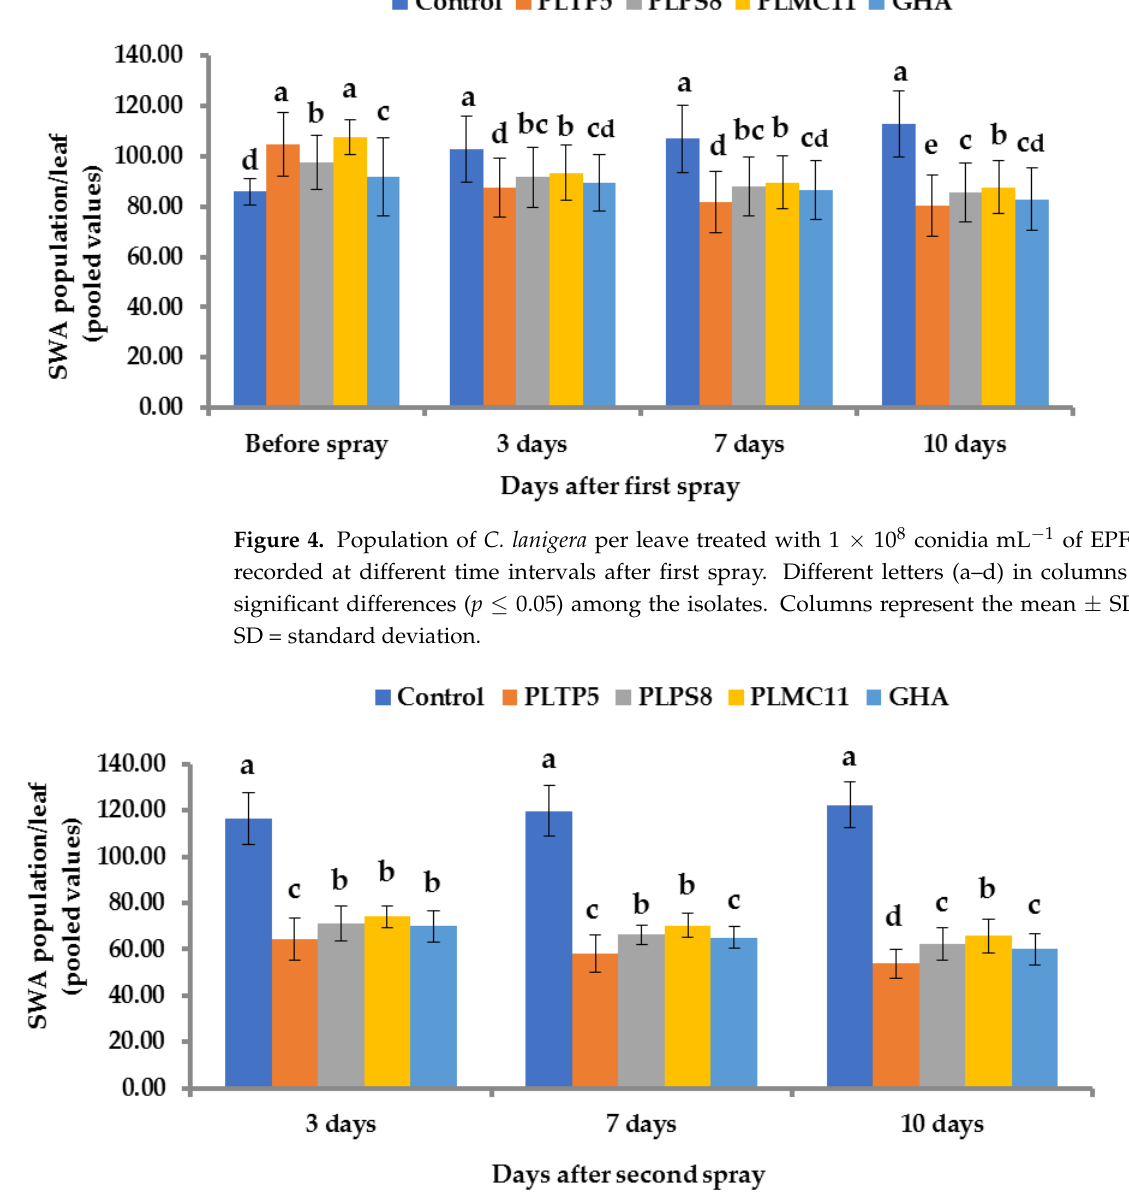
Figure 5. Population of C. lanigera per leave treated with 1 × 10 8 conidia mL − 1 of EPF isolates, recorded at different time intervals after second spray. Different letters (a–c) in columns indicate significant differences ( p ≤ 0.05) among the isolates. Columns represent the mean ± SD ( n = 3). SD = standard deviation.